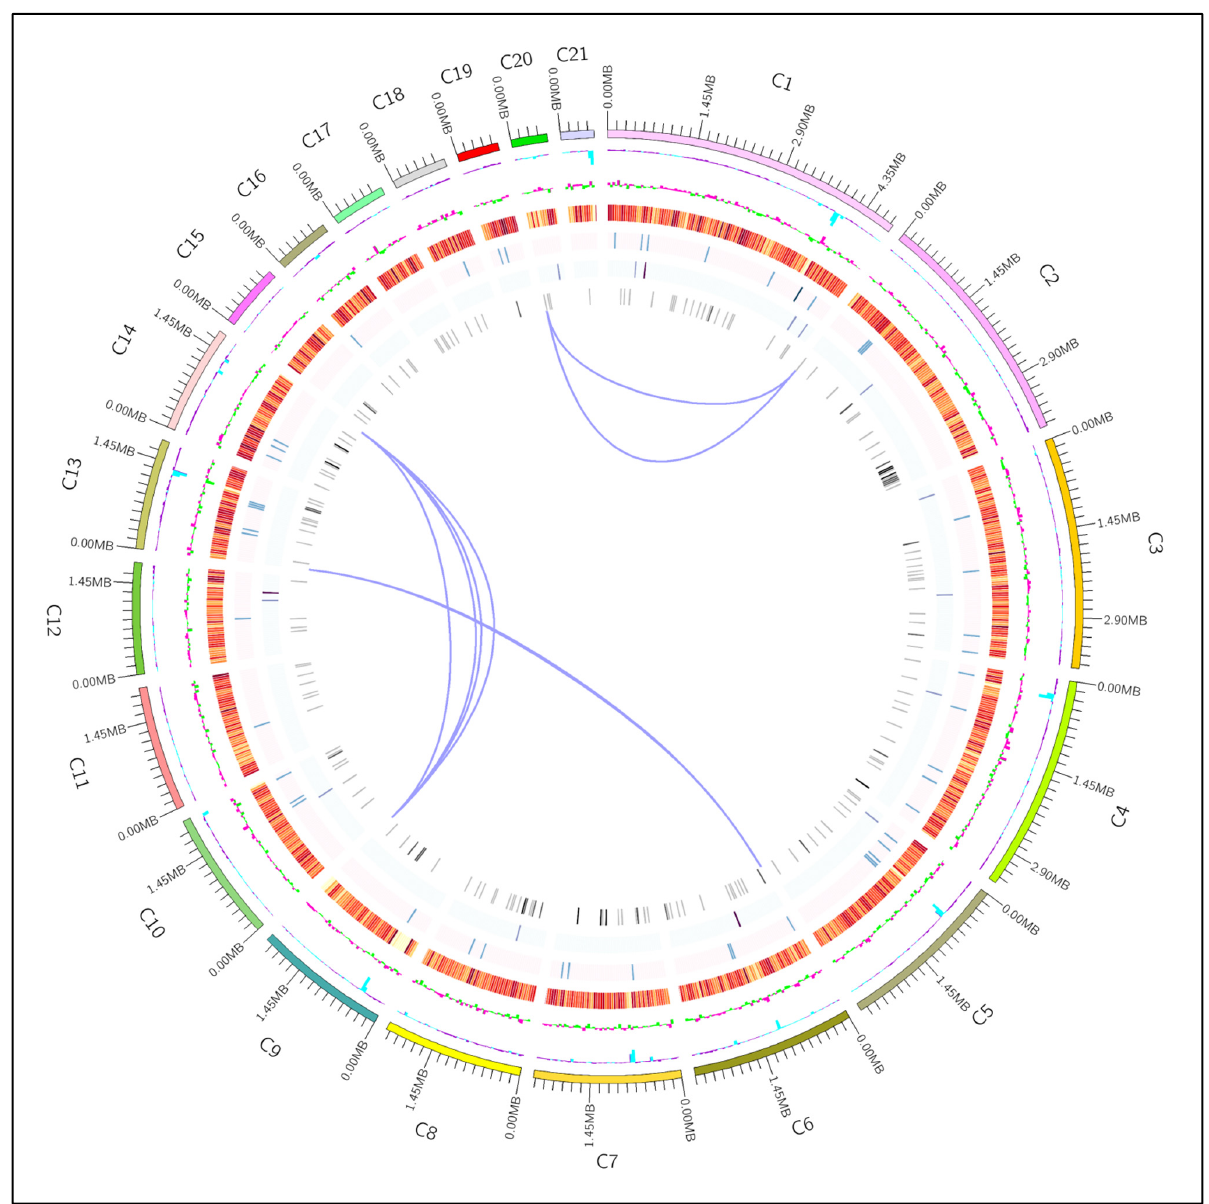
Figure 7. The circular whole-genome map of A. rasikravindrae . It is explained in the figure that from the exterior to the interior are: 1. Contigs (>1 MB in length); 2. GC content: deliberated as the % of G + C in 1 kb non-overlapping windows.